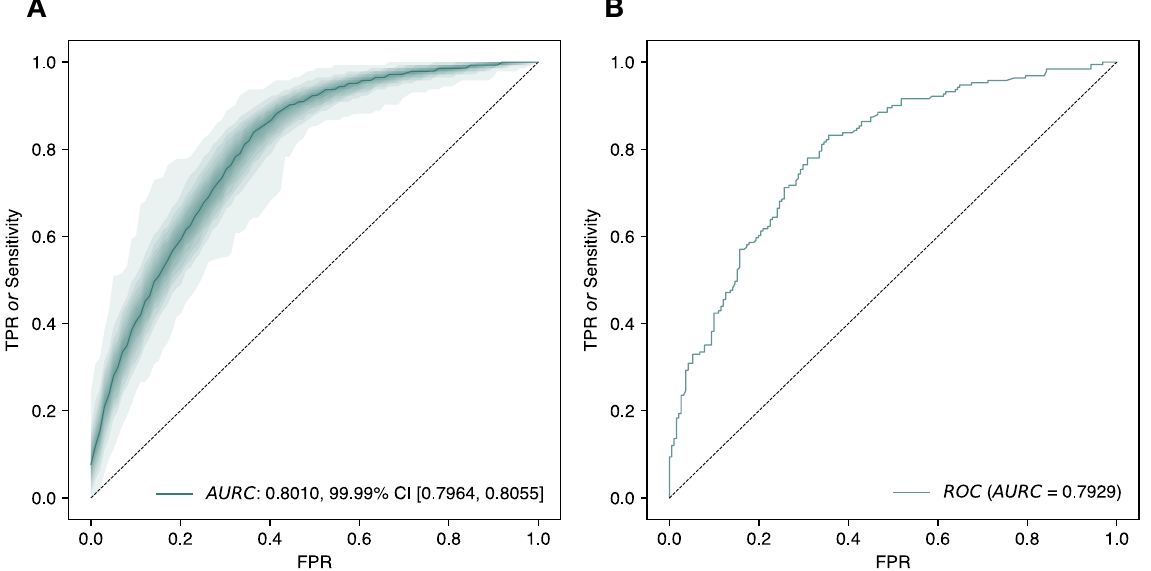
Figure 4. ROC curves of the optimized classifier (GBC algorithm). ( A ) Four-fold cross validation (100 repeats each fold) in the training set partition; the mean ROC is shown with a continuous line and the distribution of the data from 45–55 to 0–100 percentiles in ranges of 5% in the colored areas (from darker to lighter respectively). A mean AURC = 0.8010, with a 99.99% CI from 0.7964 and 0.8055, was achieved in the training set. ( B ) Final validation of the model in the test partition. Despite these data being completely new for the model, the AURC = 0.7929 was really close to the values of the training set, thus considering the model to be generalizable. The final model was trained with the whole